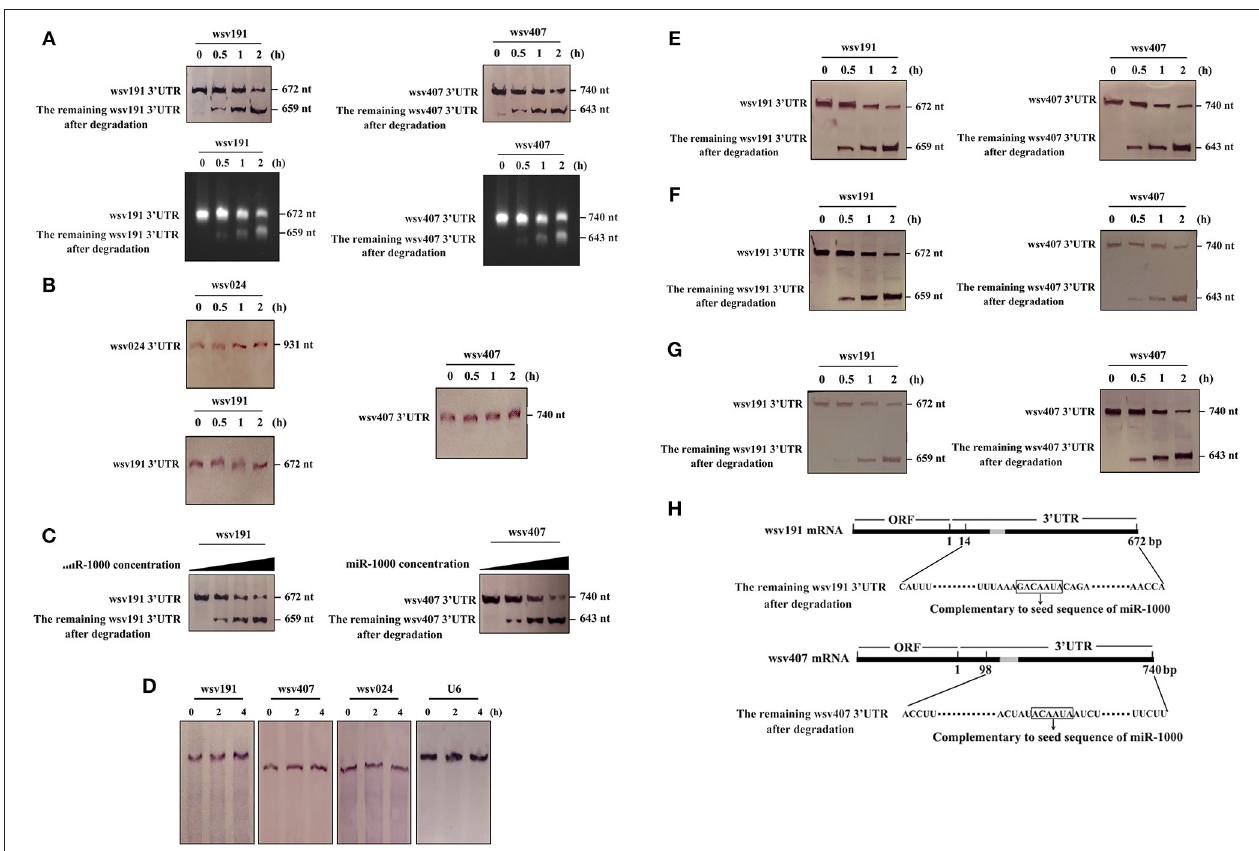
FIGURE 5 | Underlying mechanism of the miR-1000-mediated simultaneous targeting of wsv191 and wsv407 mRNAs. (A) MiR-1000-mediated time-course degradation of wsv191 and wsv407 mRNAs. The 3 ′ UTR of wsv191 mRNA or wsv407 mRNA and miR-1000 were incubated with shrimp Ago1 complex for different time intervals. The level of mRNA degradation was examined using Northern blot with wsv191- specific or wsv407 -specific probes (up) and using agarose gel electrophoresis (down). Numbers indicated the incubation time. (B) Specificity of miR-1000-mediated degradation of target mRNAs. The 3 ′ UTR of non-target gene wsv024 mRNA and miR-1000, as well as the wsv191 or wsv407 mRNA 3 ′ UTR and miR-1000-scrambled, were incubated with shrimp Ago1 complex for different time intervals, followed by Northern blot with wsv024 -specific probe (up), wsv191- specific probe or wsv407 -specific probe (down). Numbers showed the incubation time. (C) MiR-1000-concentration dependent degradation of wsv191 mRNA or wsv407 mRNA. The 3 ′ UTR of wsv191 mRNA or wsv407 mRNA and shrimp Ago1 complex were incubated with miR-1000 at different concentrations for 2h. Then the mixture was subjected to Northern blot. (D) Viral mRNA stability analysis during WSSV infection. Shrimp were injected with WSSV. Forty eighth later, the WSSV-infected shrimp were treated with actinomycin D. At different time points after treatment, shrimp were subjected to Northern blotting to detect wsv191 , wsv407, and wsv024 mRNAs. (E) MiR-1000-mediated synchronous degradation of wsv191 mRNA and wsv407 mRNA. The 3 ′ UTRs of wsv191 mRNA and wsv407 mRNA as well as miR-1000 were simultaneously incubated with shrimp Ago1 complex for different time intervals. Subsequently, the mixture was analyzed by Northern blot. (F,G) Competitive degradation assays of wsv191 and wsv407 mRNA 3 ′ UTRs mediated by miR-1000. To assess the competitive degradation between wsv191 and wsv407 mRNA 3 ′ UTRs, 10-fold concentration of wsv191 mRNA 3 ′ UTR and 1-fold concentration of wsv407 mRNA 3 ′ UTR (F) or 1-fold concentration of wsv191 mRNA 3 ′ UTR and 10-fold concentration of wsv407 mRNA 3 ′ UTR (G) were mixed and then incubated with miR-1000 together with shrimp Ago1 complex for different time intervals. The mixture was analyzed by Northern blot. (H) Sequencing of degraded 3 ′ UTRs of wsv191 mRNA and wsv407 mRNA. The arrows indicated the sequences of wsv191 mRNA 3 ′ UTR and wsv407 mRNA 3 ′ UTR complementary to the seed sequence of